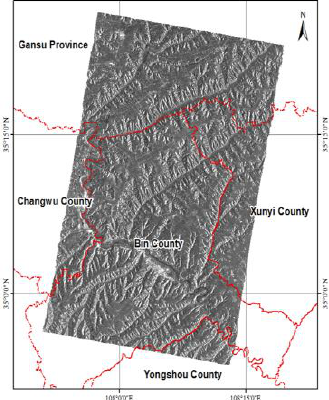
Figure 1. Range of the test site